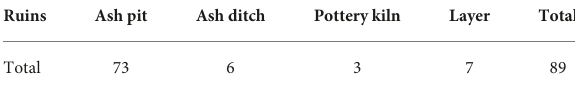
TABLE 1 Merged samples at the Wanfunao site from 2015 to 2017.